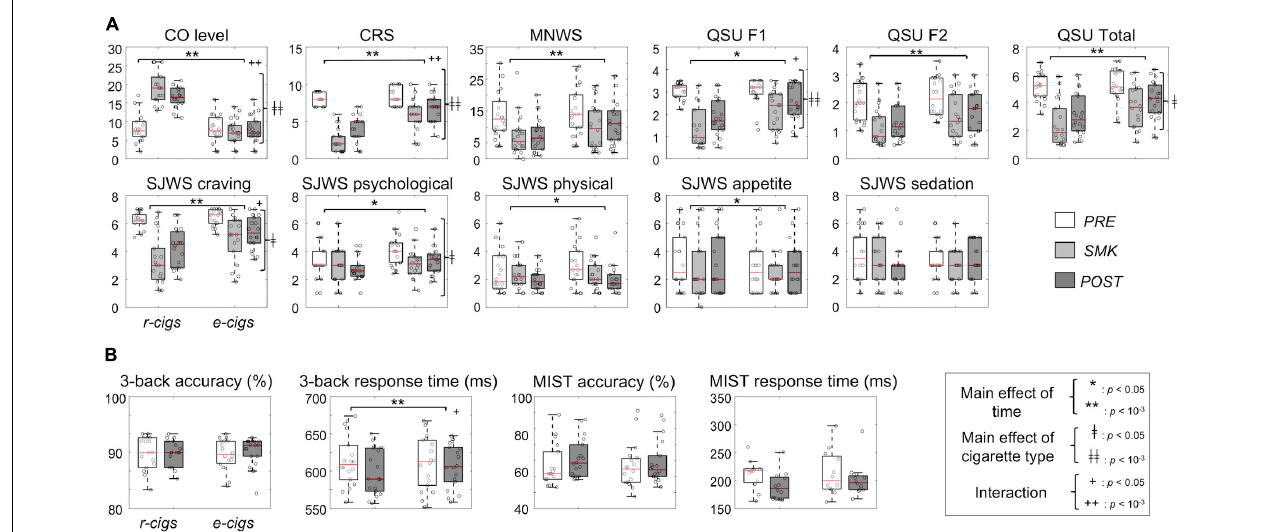
FIGURE 2 | Behavioral data analysis: (A) Physiological data across the three time points on an experimental day (i.e., PRE, pre-MRI; SMK, after smoking; POST, post-MRI) and two cigarette types and (B) accuracy and response time of the cognitive tasks between the two time points (i.e., PRE and POST) and two cigarette types. The p -value was Bonferroni-corrected. CO, carbon monoxide; MNWS, Minnesota Withdrawal Scale; QSU, Questionnaire on Smoking Urges; SJWS, Shiffman-Jarvik Withdrawal Scale – Short Version; r-cigs, regular tobacco cigarettes; e-cigs, electronic cigarettes; RT, response time; MIST, Montreal Imaging Stress